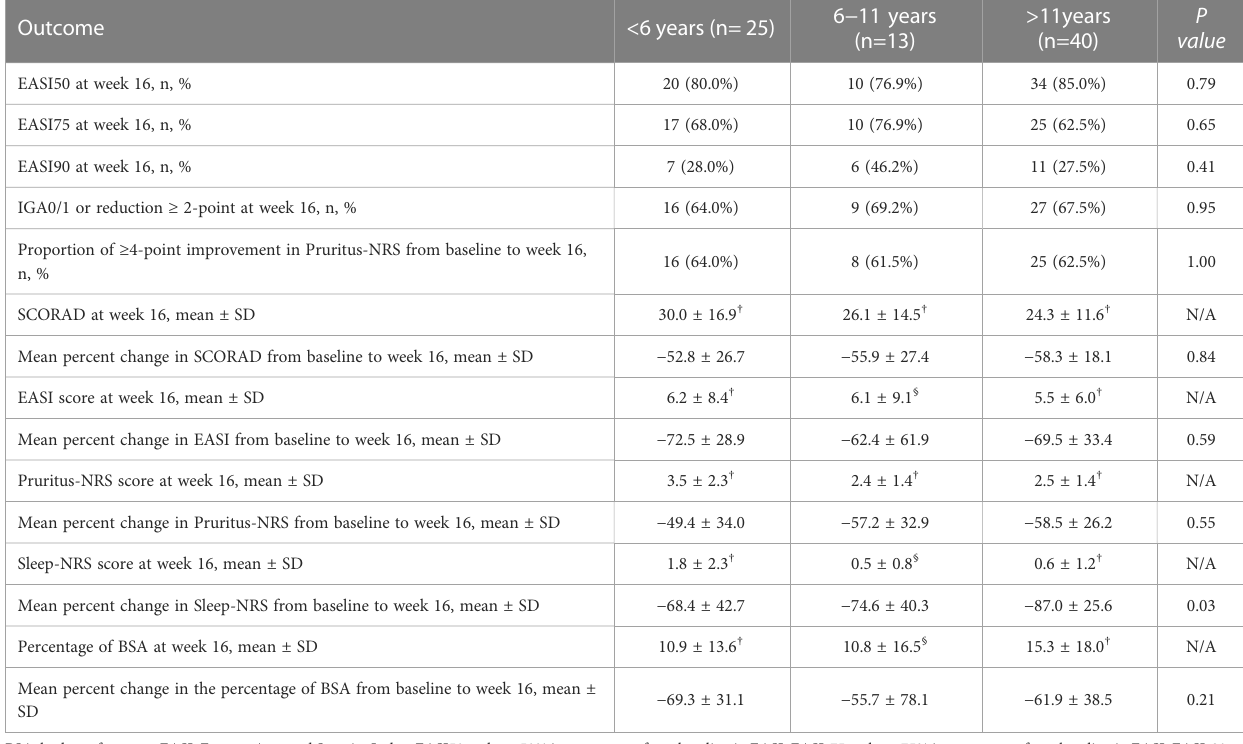
TABLE 2 Outcomes after dupilumab treatment at week 16.